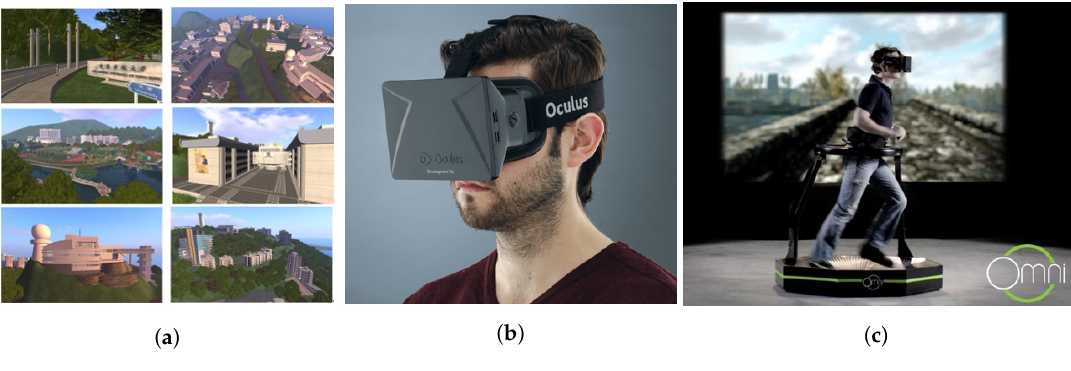
Figure 11. Implementation of Immersive Virtual Geographic Cognitive Environments. ( a ) Virtual urban environment (Virtual CUHK Campus as a case study); ( b ) Immersive virtual-reality headset (Oculus Rift from Samsung); ( c ) Immersive movement platform (Virtuix Omni). (b) Real-Time Collaborative Sensing with Mobile EEG Device EEG is an electrophysiological monitoring method to record electrical activity of the brain.